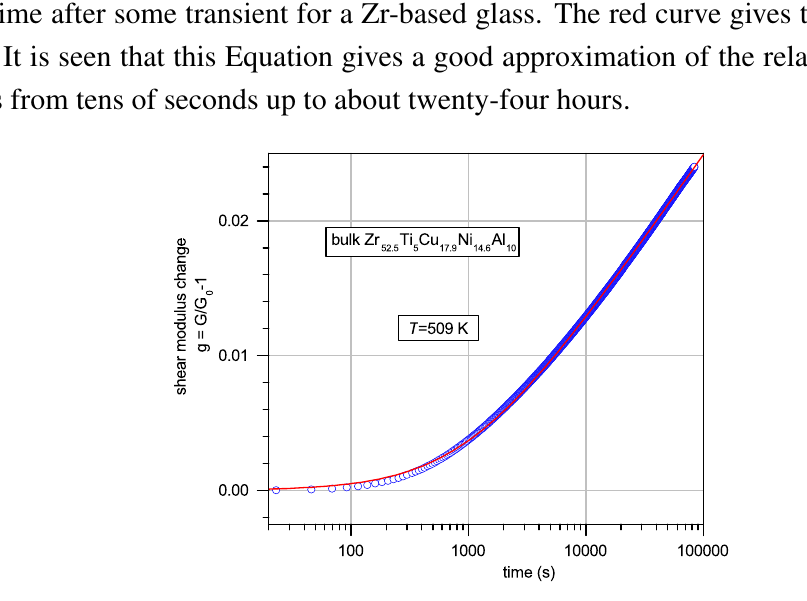
Figure 3. Time dependence of the shear modulus change upon isothermal annealing of T i Cu Ni Al bulk glassy Zr at T = 509 K. The solid red curve gives the fit using 52 : 5 5 17 : 9 14 : 6 10 Equation (4). Reprinted with permission from American Physical Society, 2008